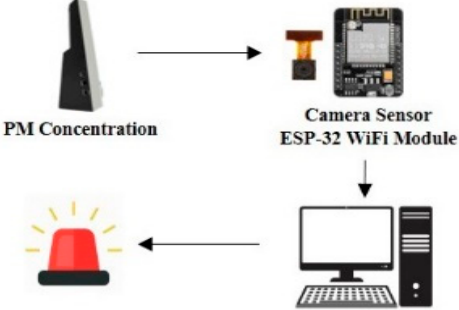
Figure 5. Overview of the data communication module system.